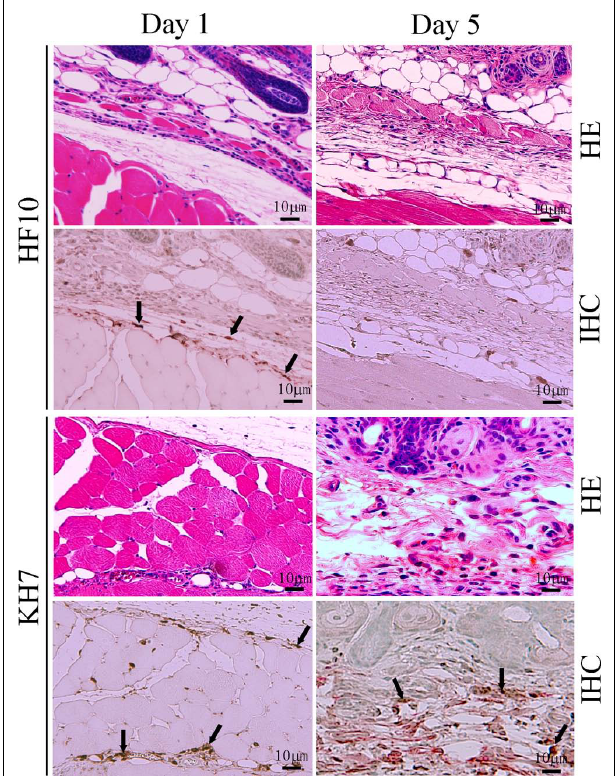
FIGURE 1 | Safety study of HF10 in a nude mouse model. HSV-1 mutant HF10 or HSV-1 wild-type KH7 was subcutaneously inoculated into BALB/c nude mice. Skin samples were obtained at days 1 and 5 after infection and evaluated by hematoxylin and eosin (HE) staining and immunohistochemistry (IHC) to detect HSV-1 antigens. Arrows indicate HSV-1-infected